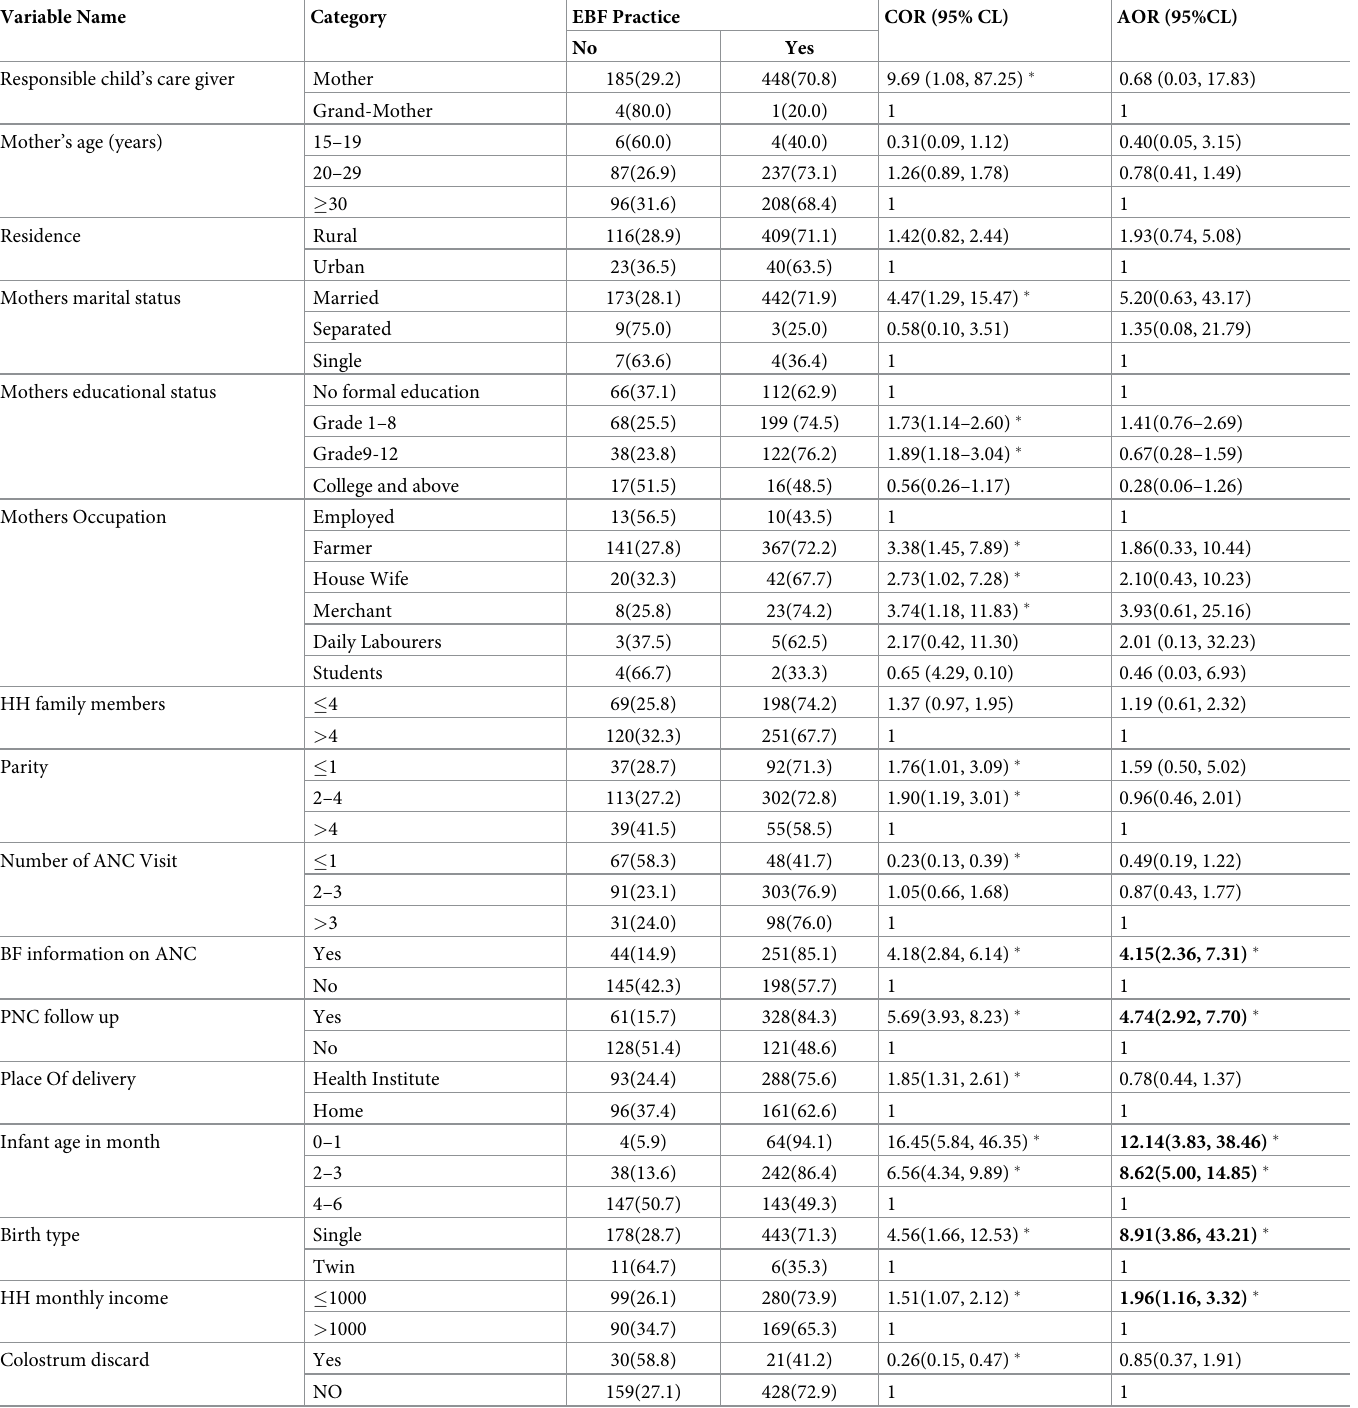
Table 4. Factors associated with EBF practice of mothers among study participants (n =